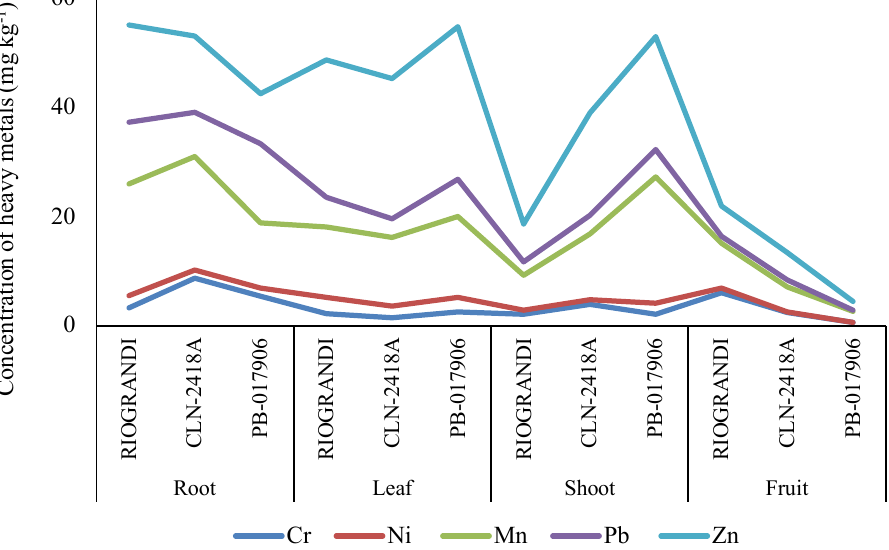
Figure 1. Heavy metals (HMs) accumulation in tomato fruit under the controlled environmental conditions. Abbreviations: Cr: chromium, Ni: nickel, Mn: manganese, Zn: zinc, Pb: lead.